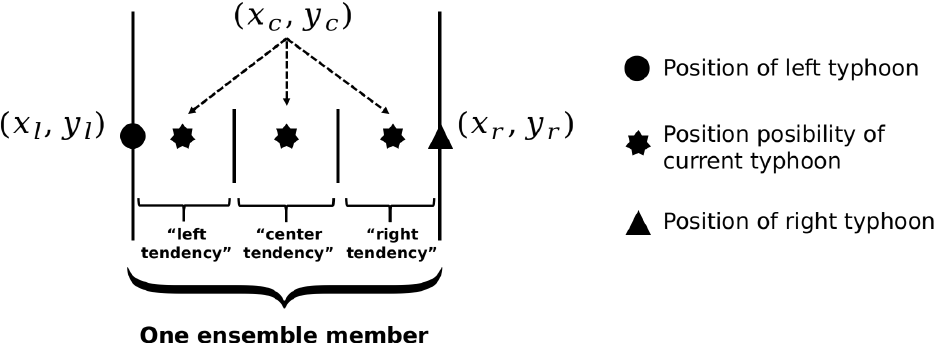
Figure 5. Determination of the class tendency of the current typhoon class and construction of an ensemble